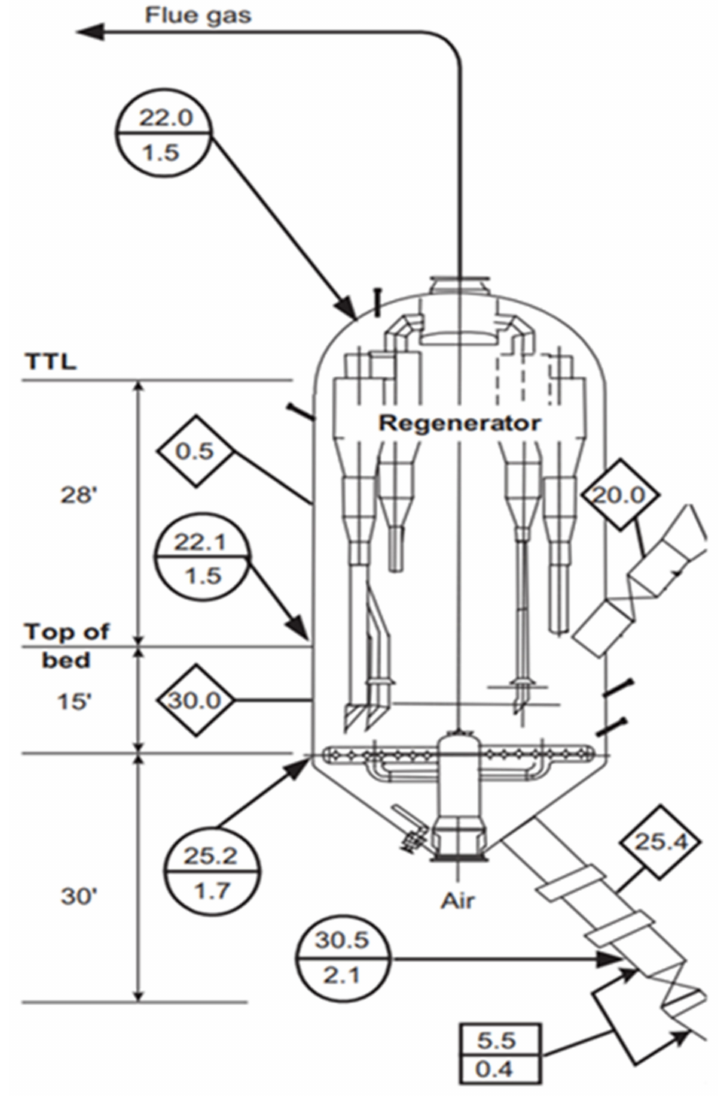
Figure 22. Pressure-monitoring taps in a FCCU regenerator. Modified from Sadeghbeigi